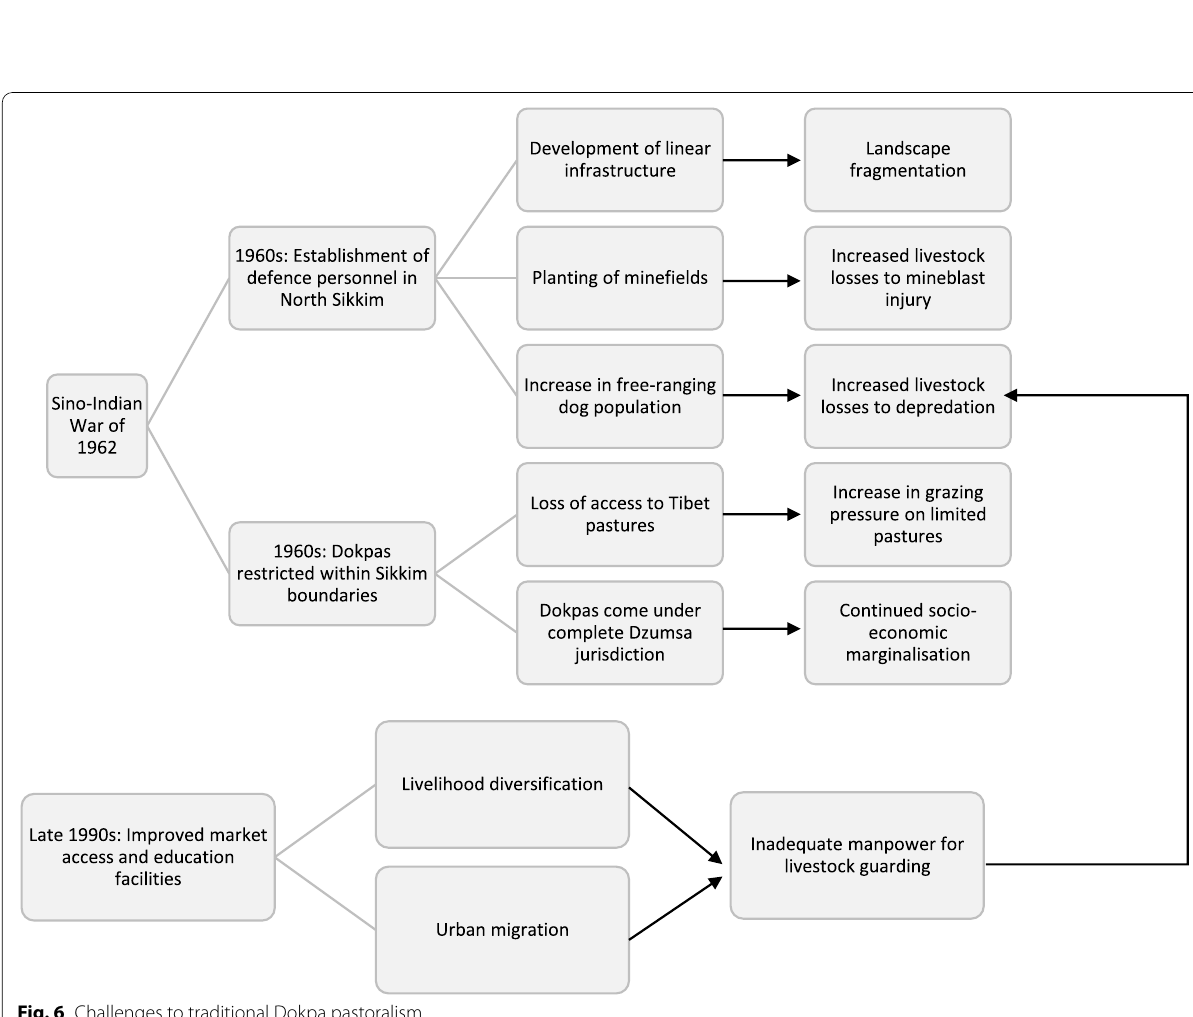
Fig. 6 Challenges to traditional Dokpa